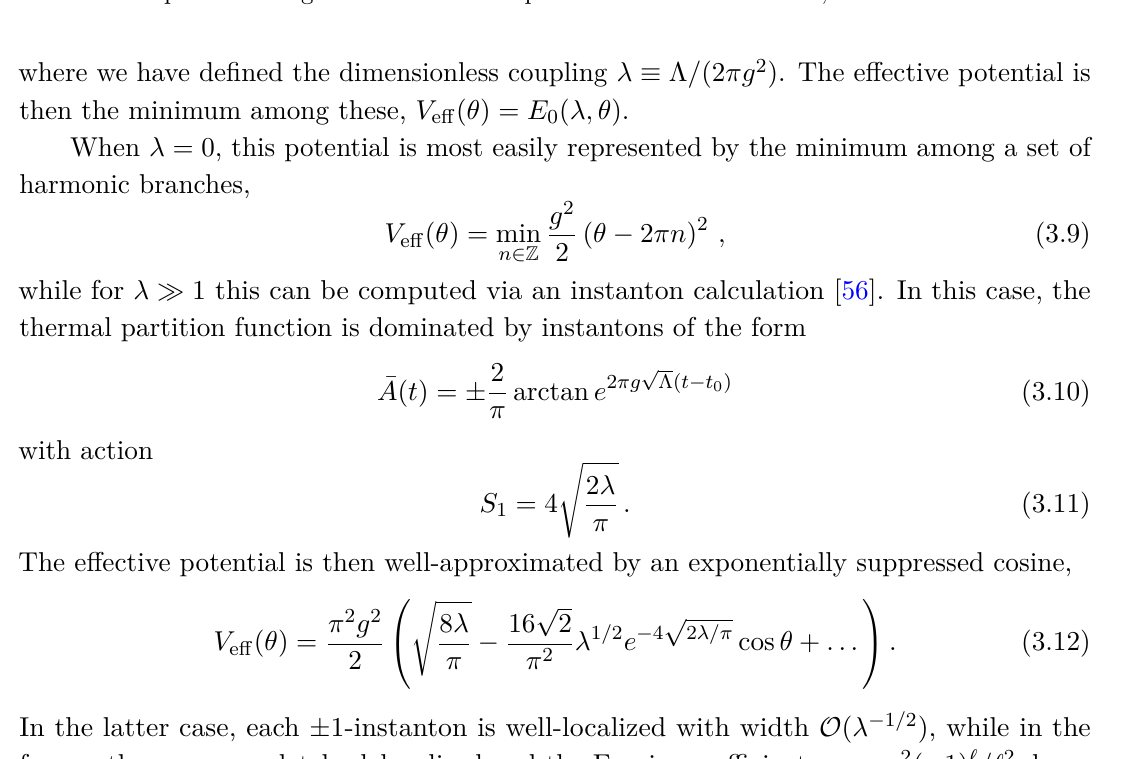
Figure 4. The lowest energy eigenvalues (in units of π 2 g 2 / 2 ) of the toy model (3.3) for various values of the potential height λ . The effective potential is the lowest level, shown in